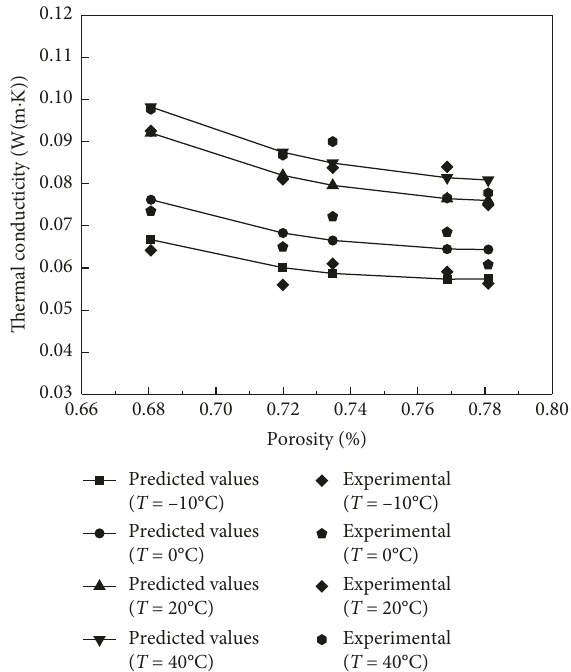
Figure 8: Comparison between the theoretical and experimental results at different